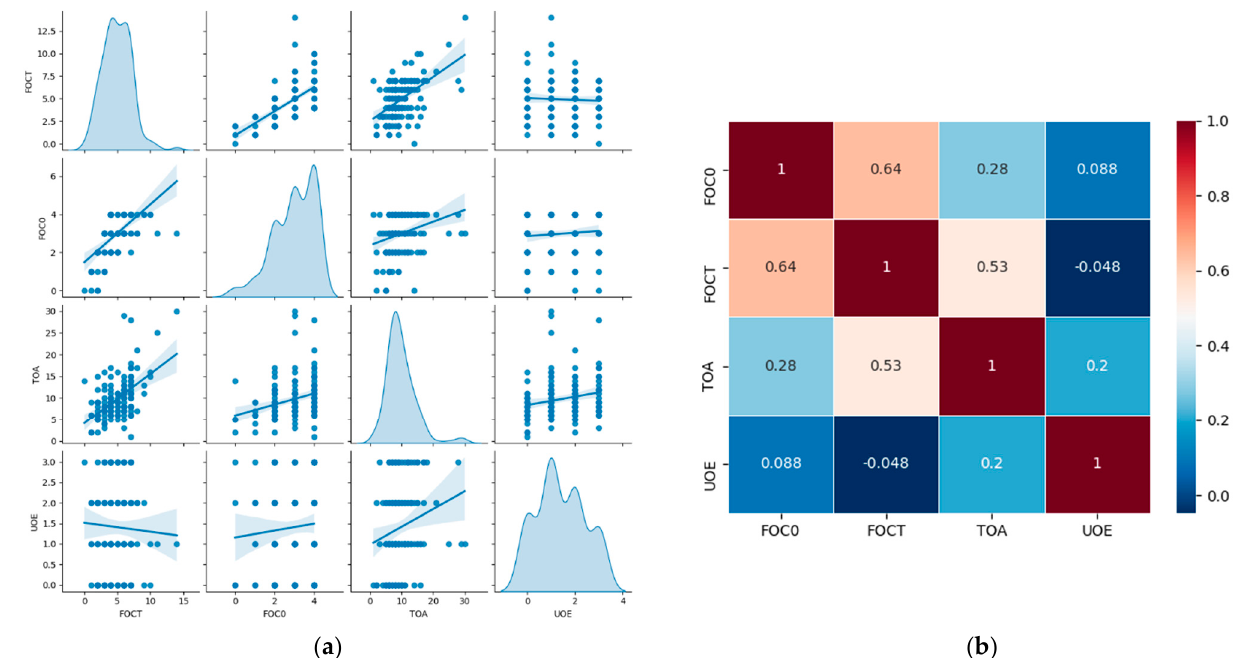
Figure 7. Regression analysis between personal feelings, traffic accessibility, and urbanization: ( a ) pair plot of citizen feelings in valuable functions; ( b ) heatmap of citizen feeling indexes of Pearson correlation. The heatmap turns the pair plot into quantified values for more accurate comparison. The correlation value is between 0 and 1. When the value is bigger, the correlation between the two functions is higher.